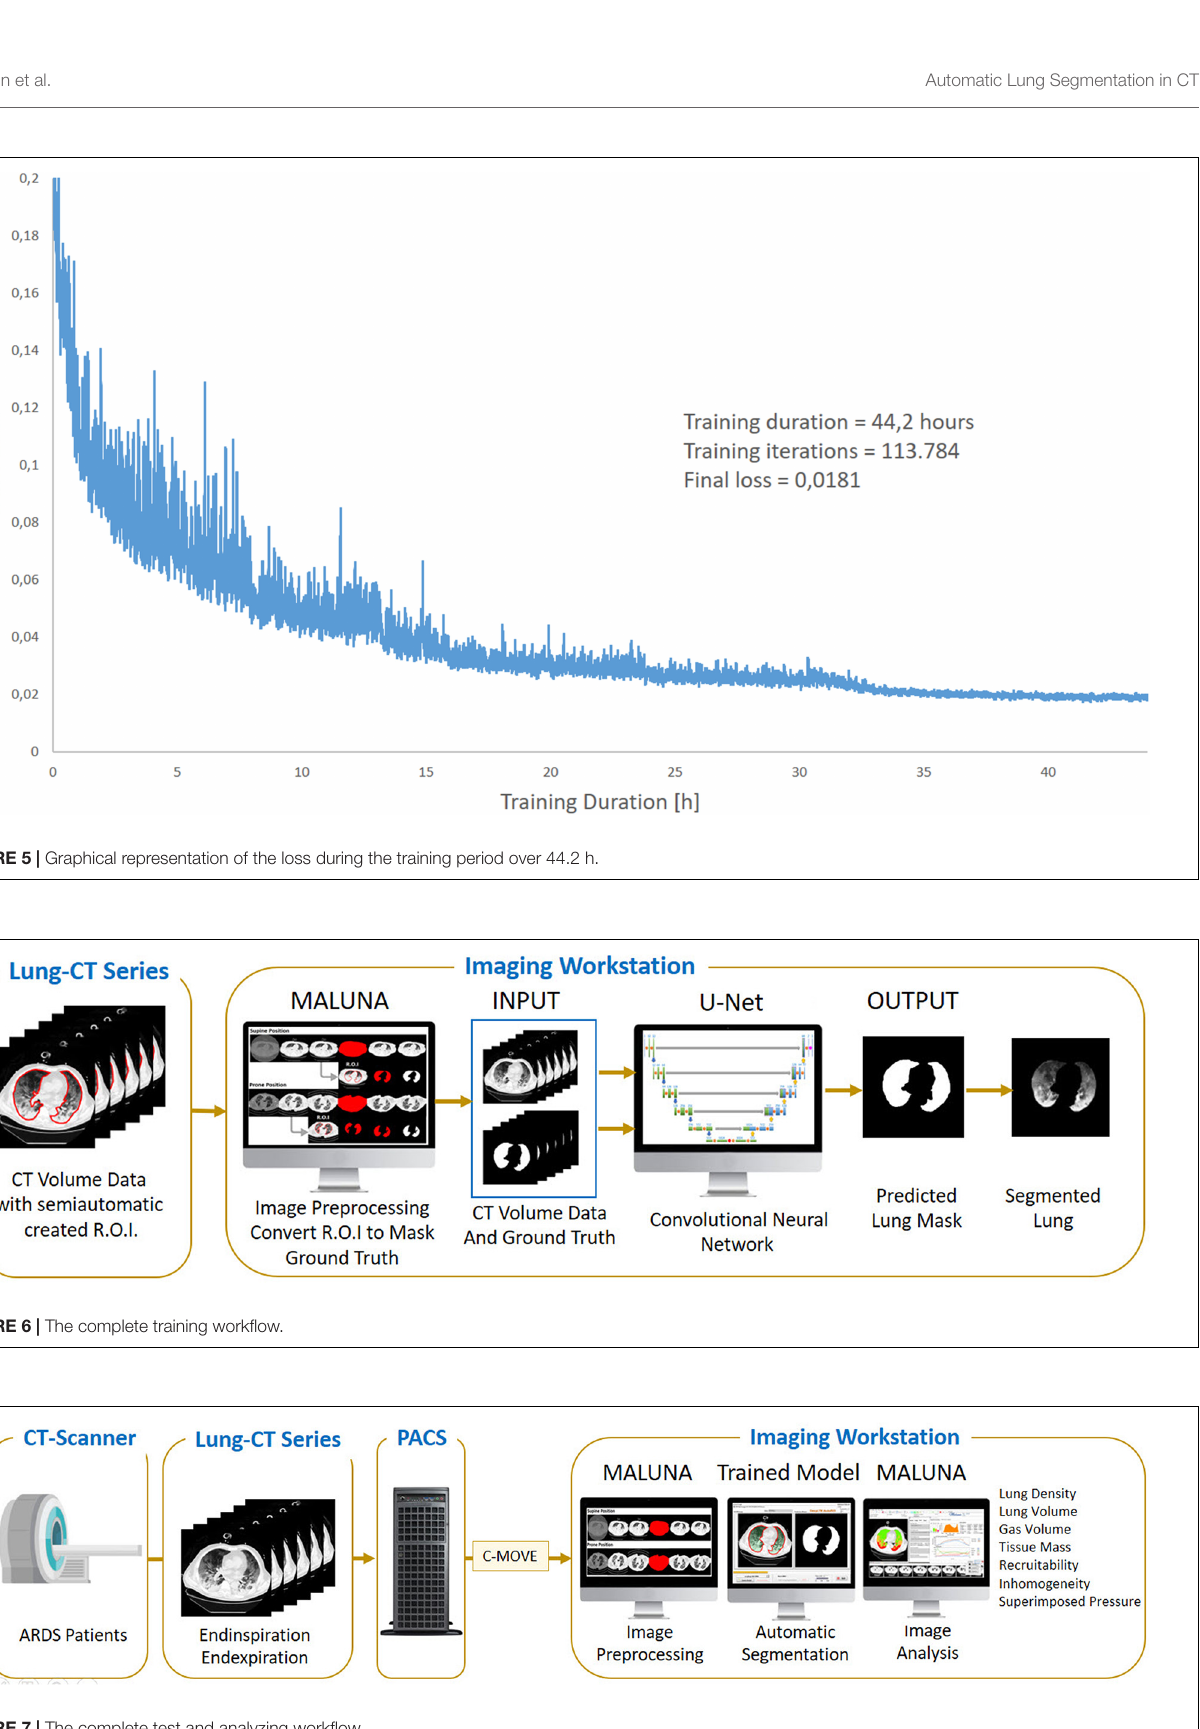
FIGURE 7 | The complete test and analyzing